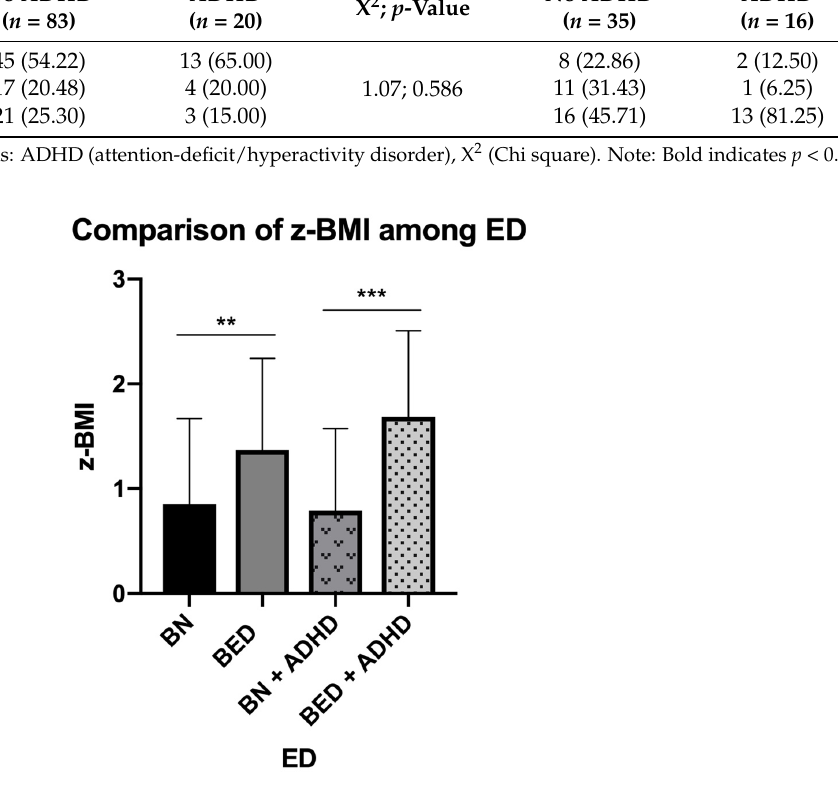
Figure 1. Comorbidity among patients with an eating disorder. Abbreviations: AN, anorexia nervosa; BN, bulimia nervosa; BED, binge eating disorder. Table 3. Comparisons between BMI diagnoses in patients with BN and BED with the presence or absence of ADHD in the Mexican adolescent population. Bulimia Nervosa Binge Eating Disorder BMI Diagnoses